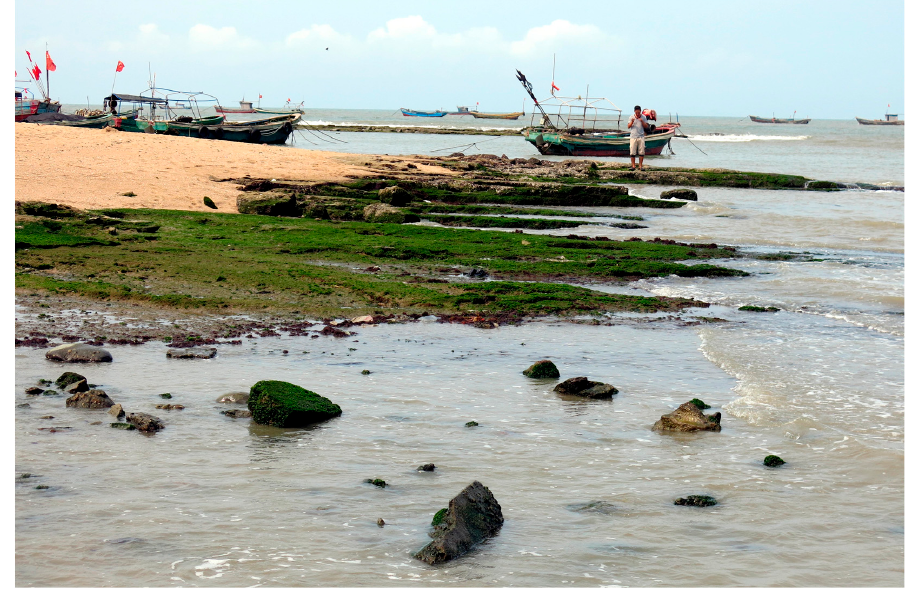
Figure 7. Ying Ge Hai, Ulva spp. belt, the middle intertidal zone, April 2014.